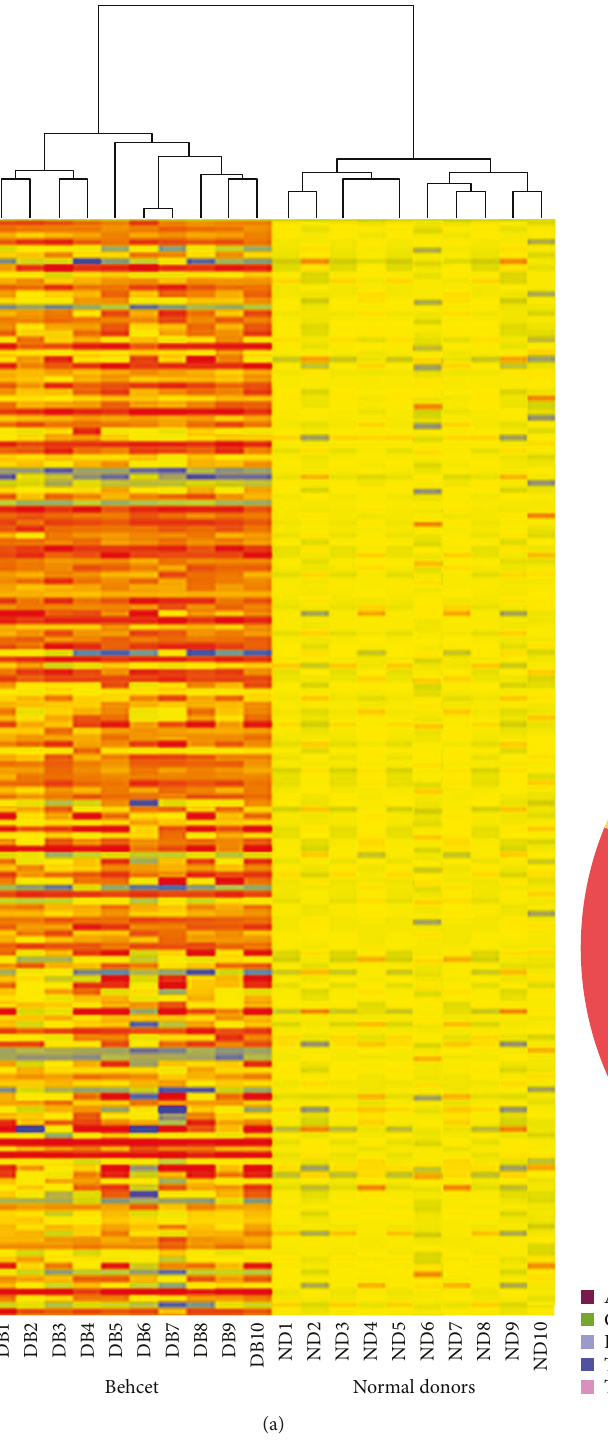
Figure 1: Modulated genes in PBCs of 10 BD patients and their functional classi fi cation. Heat map of signi fi cantly modulated genes (a). Each row represents a gene, each column shows the expression of selected genes in each individual sample. Blue-violet indicates genes that are expressed at lower levels when compared with the mean value of the control subjects, orange-red indicates genes that are expressed at higher levels when compared to the control means, and yellow indicates genes whose expression levels are similar to the control mean. Panel (b) shows the functional categorization of BD modulated genes according to GO terms. In the legend, the gene classes are listed in a clock-wise order starting at the “ 12 o ’ clock ”